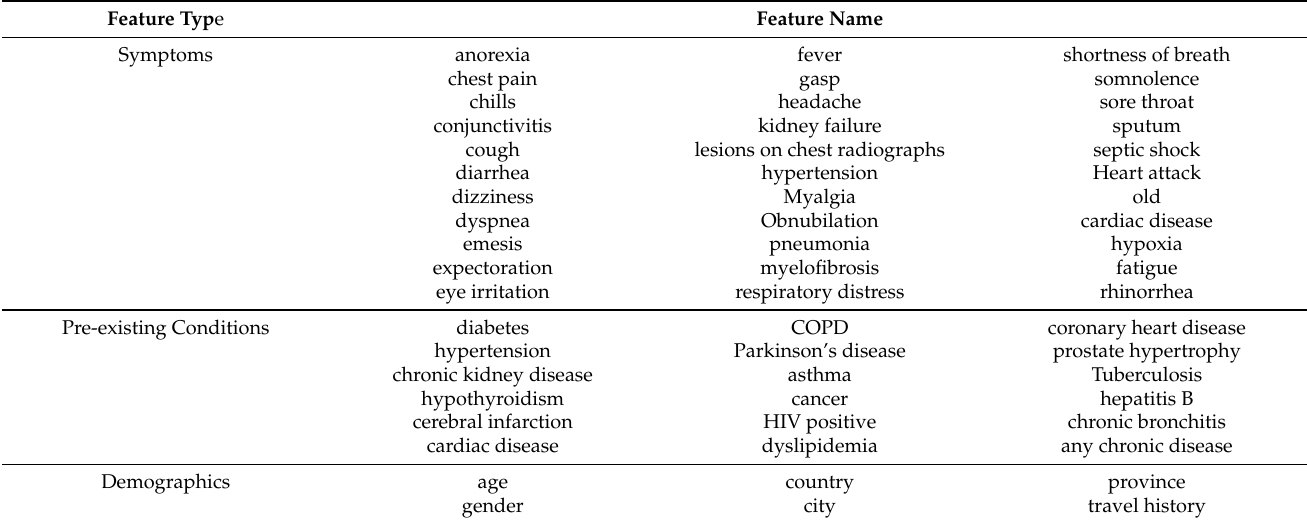
Table 2. The list of the 57 selected features used in our predictive